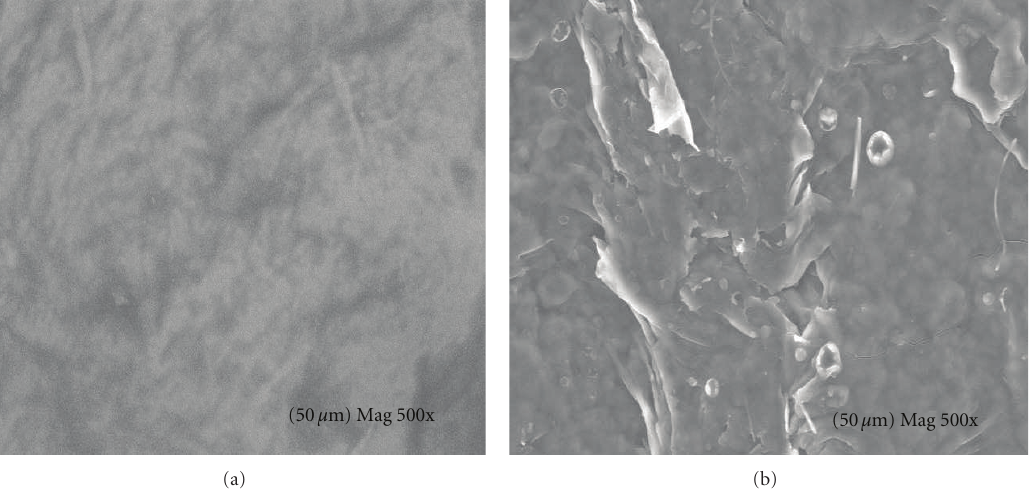
Figure 4: SEM images of surface morphology of Graphite oxide paper. (a) Surface of fresh GO paper. (b) Surface of GO paper removed from MEA after